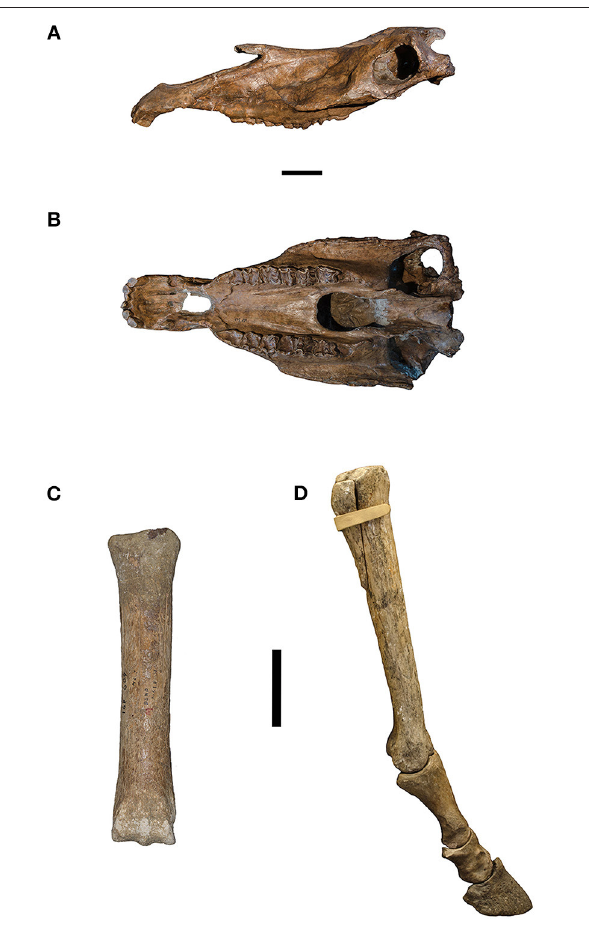
FIGURE 5 | Equus stehlini . (A) Skull in lateral view; (B) Skull in ventral view; (C) MCIII in dorsal view; (D) Forelimb in lateral view.